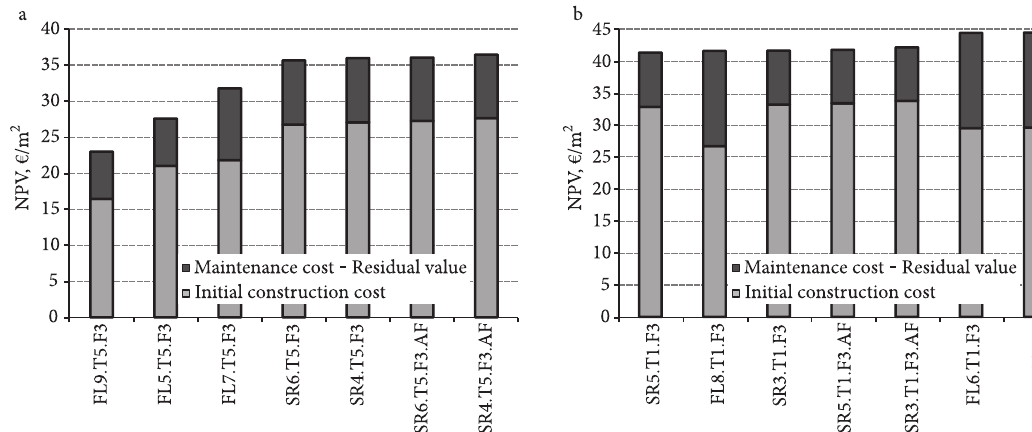
Fig. 2. Total NPV associated with pavement structures: a – traffic T5; b – traffic T1